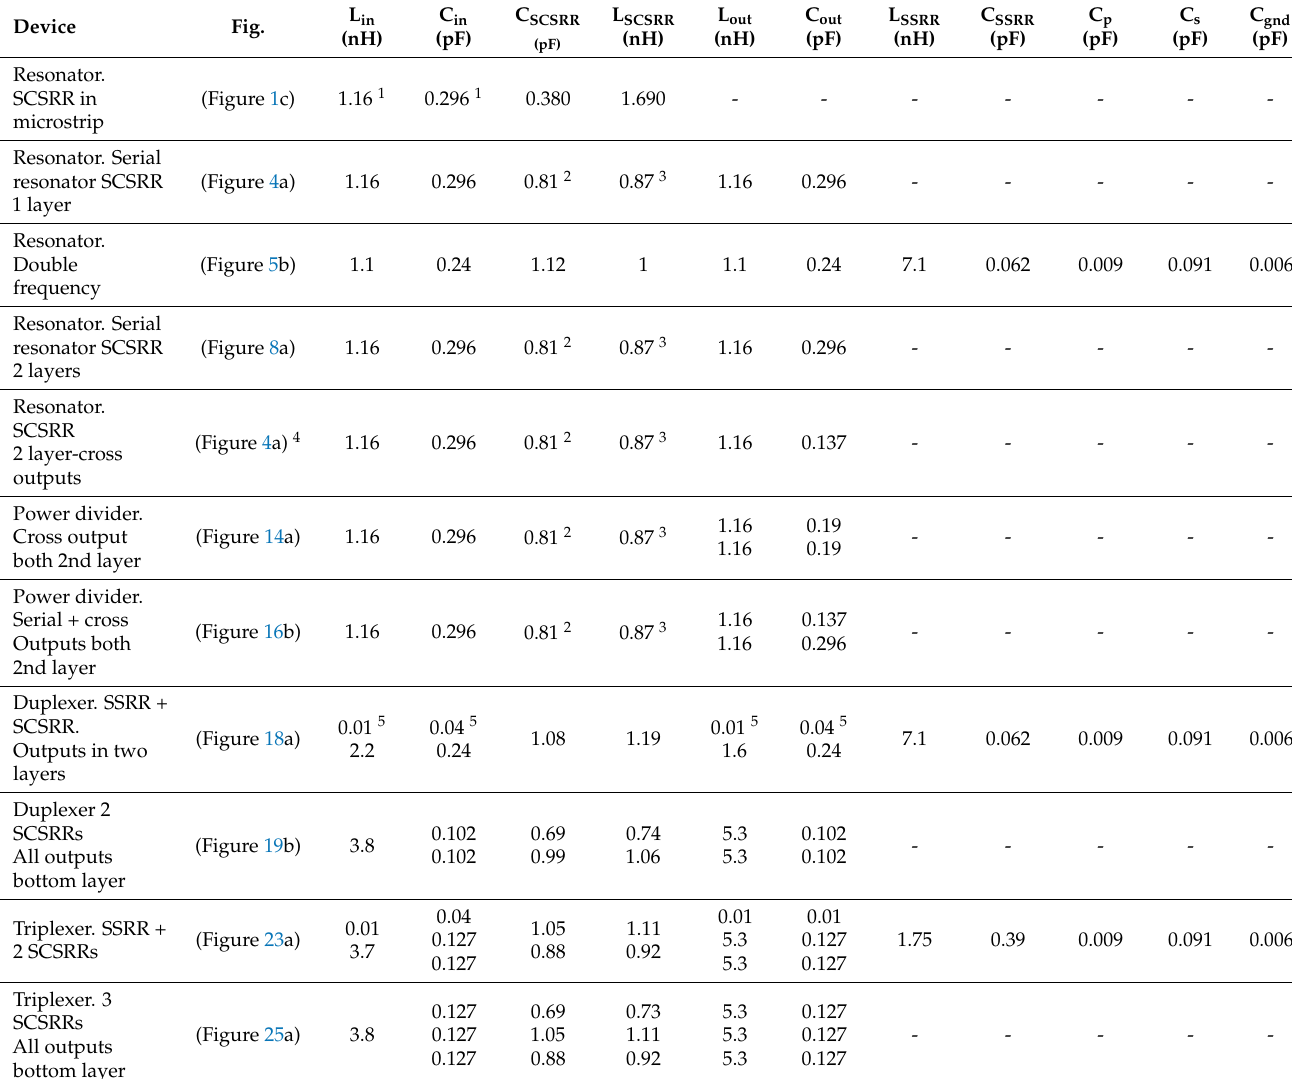
Table 6. Equivalent circuits, parameters, and